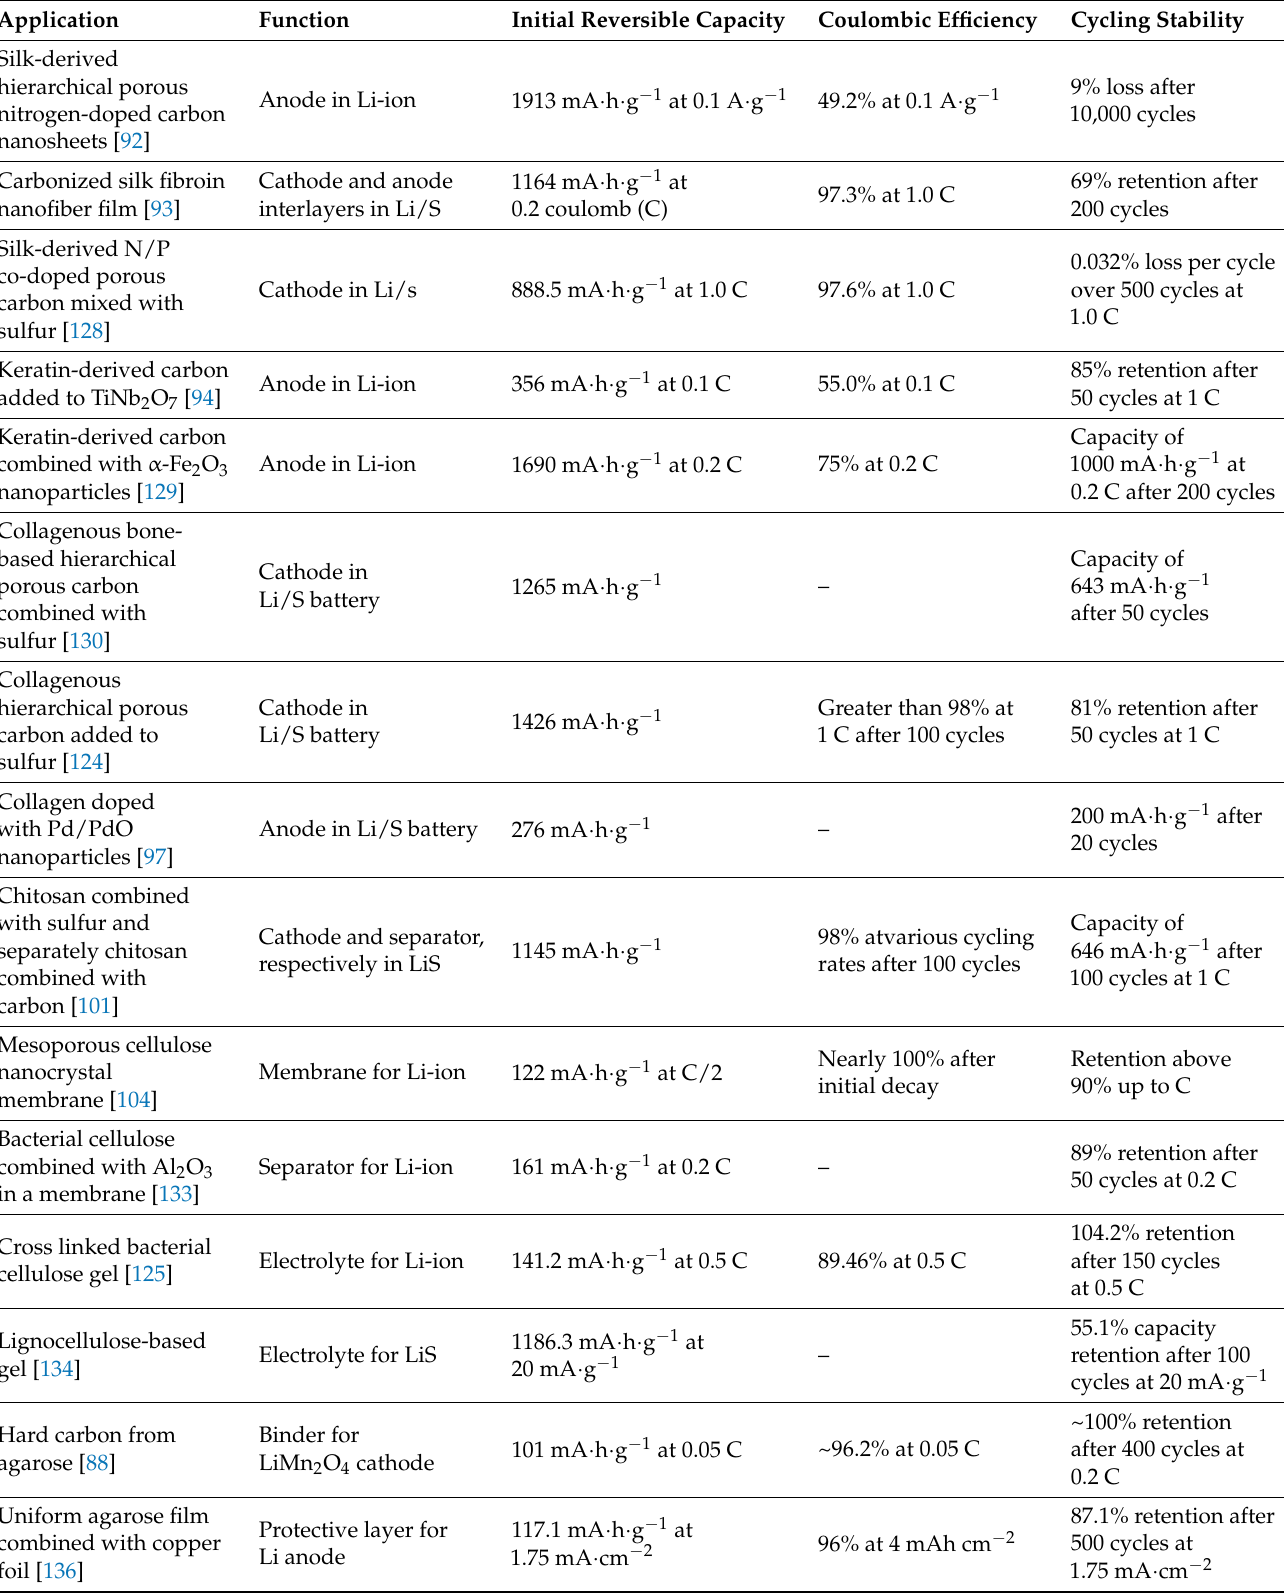
Table 2. Biopolymer applications as lithium battery